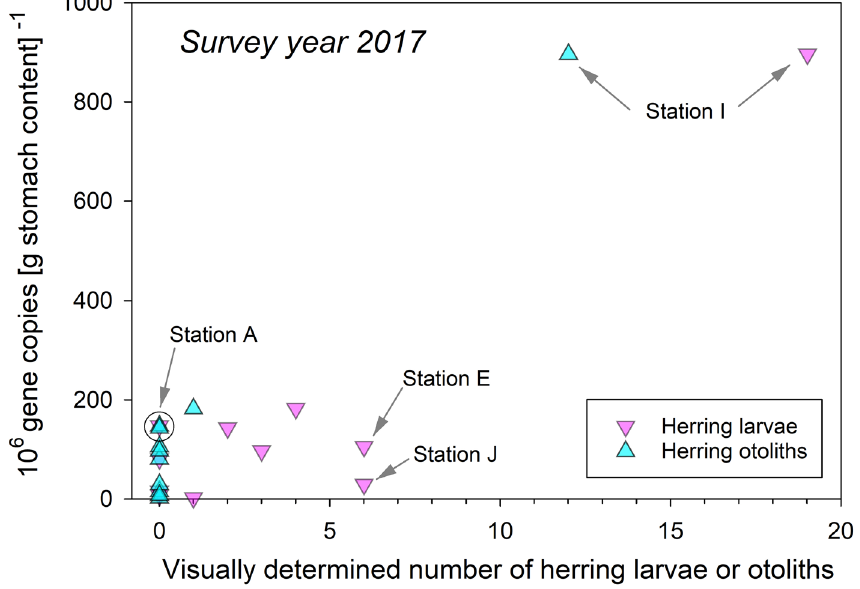
Figure 3. Results of visual examination of mackerel stomachs in June 2017 for presence of herring larvae and otoliths in relation to the corresponding number of mt16S gene copies, split by sampling station. Geographical locations of marked stations are shown in Fig.